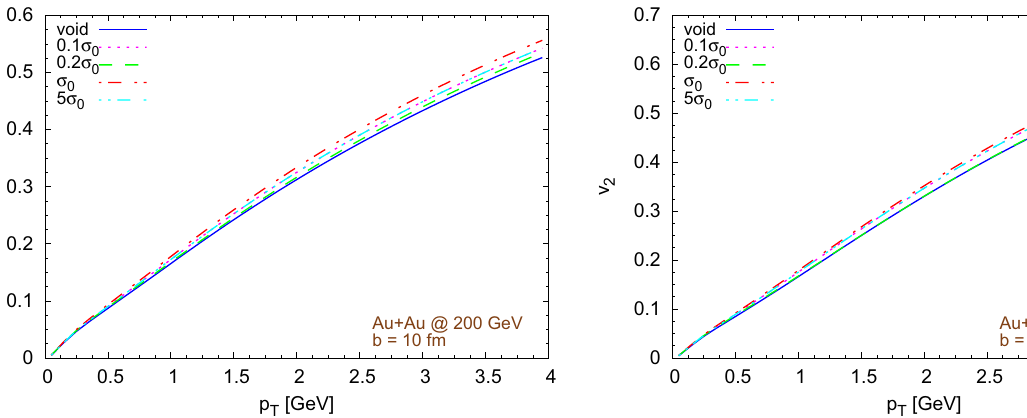
Fig. 8 Evaluation of the impact of different initial magnetic fields on v ( p , y = 0 ) , computed by assuming different electrical and mag- T 2 netic chiral conductivities of the medium in the pre-equilibrium phase